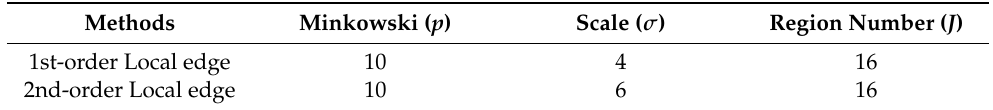
Table 2. Parameter settings in the proposed 1st-order Local edge and 2nd-order Local edge color constancy methods. Noted that the parameters are empirical.